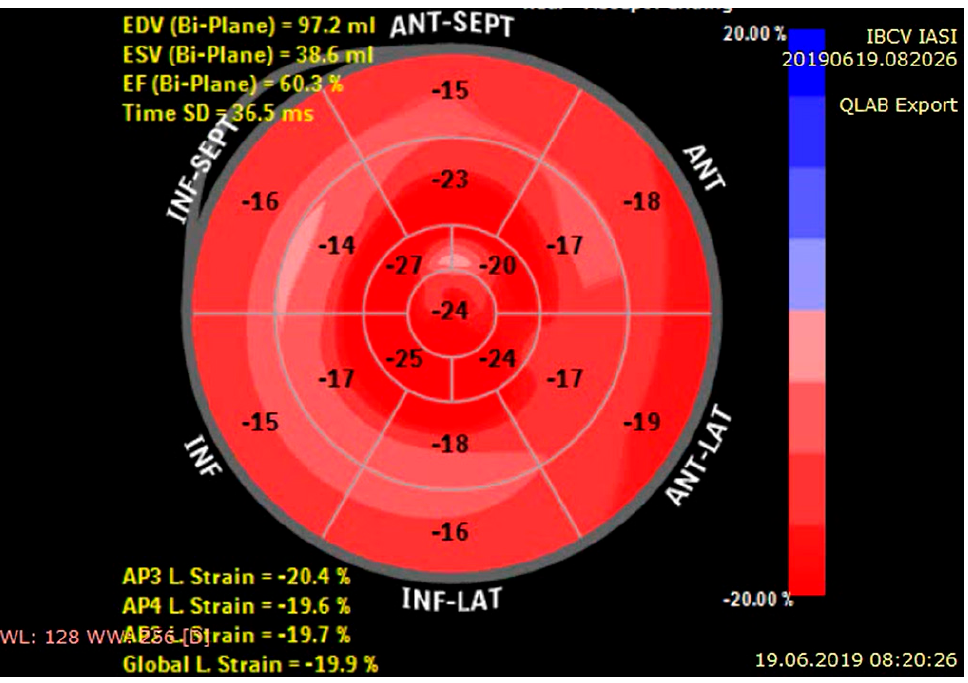
Figure 4. Distinctive bull ′ s-eye plot in cardiac amyloidosis, with slight impairment of the global longitudinal strain (GLS) in the basal and mid-ventricular segments and relative apical-sparing.